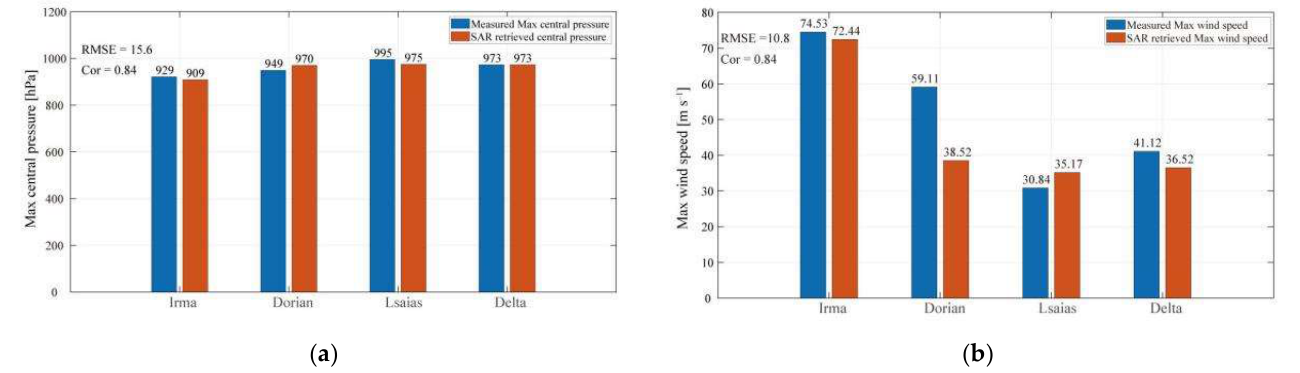
Figure 5. Comparison between SAR-derived TC parameters and SFMR observations. ( a ) Central pressure and ( b ) maximum wind speed.